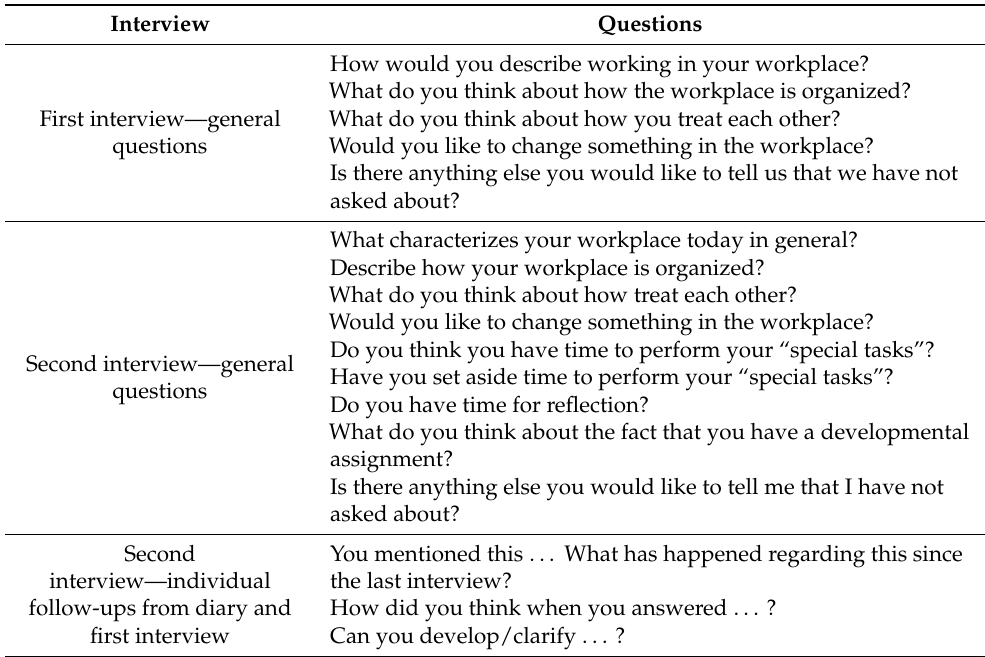
Table 1. General questions in the semi-structured interview